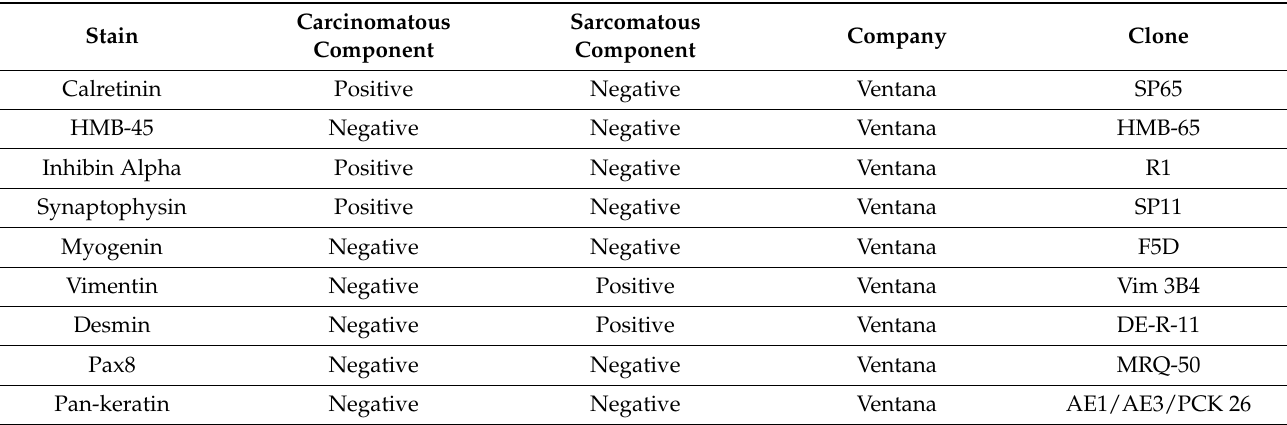
Table 1. Immunohistochemical staining in carcinomatous and sarcomatous components. All of the antibodies used in the immunology lab are pre-diluted by the manufacturing company as listed in the table.